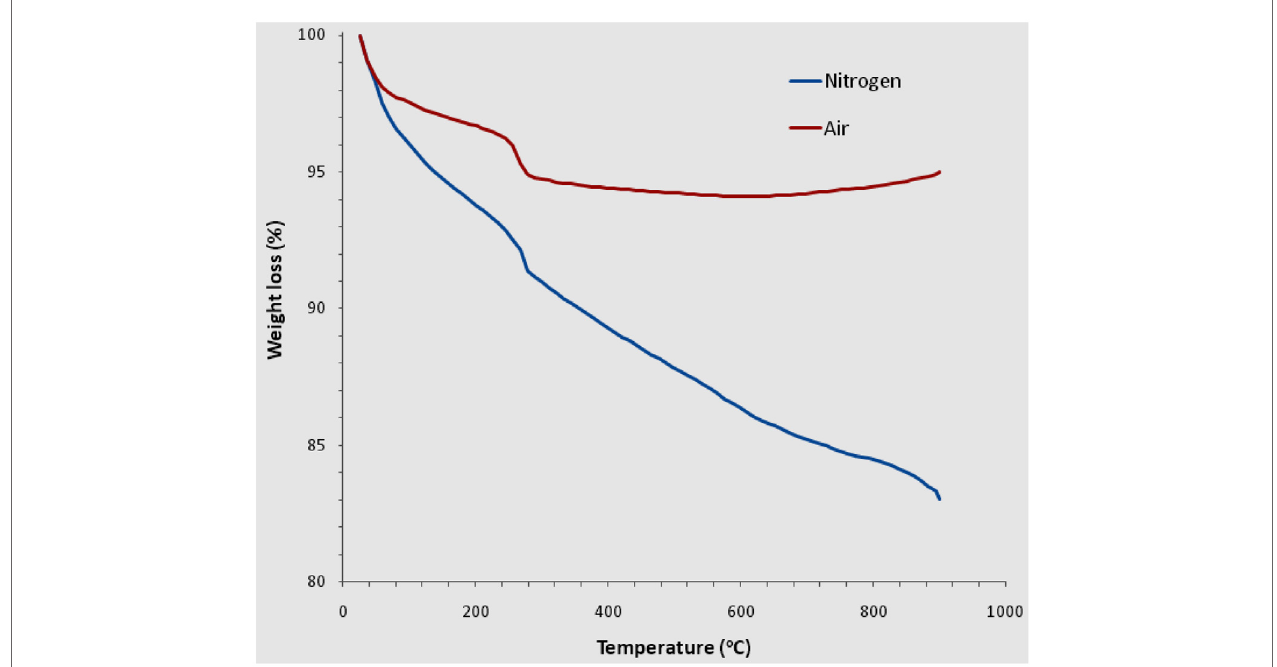
FigUre 5 | Tga analysis, in both air and nitrogen atmosphere, of the catalyst (nickel formate coated on fumed silica) to show the sample weight loss caused by thermal decomposition of the nickel precursor and the removal of water from the micropores of silica .